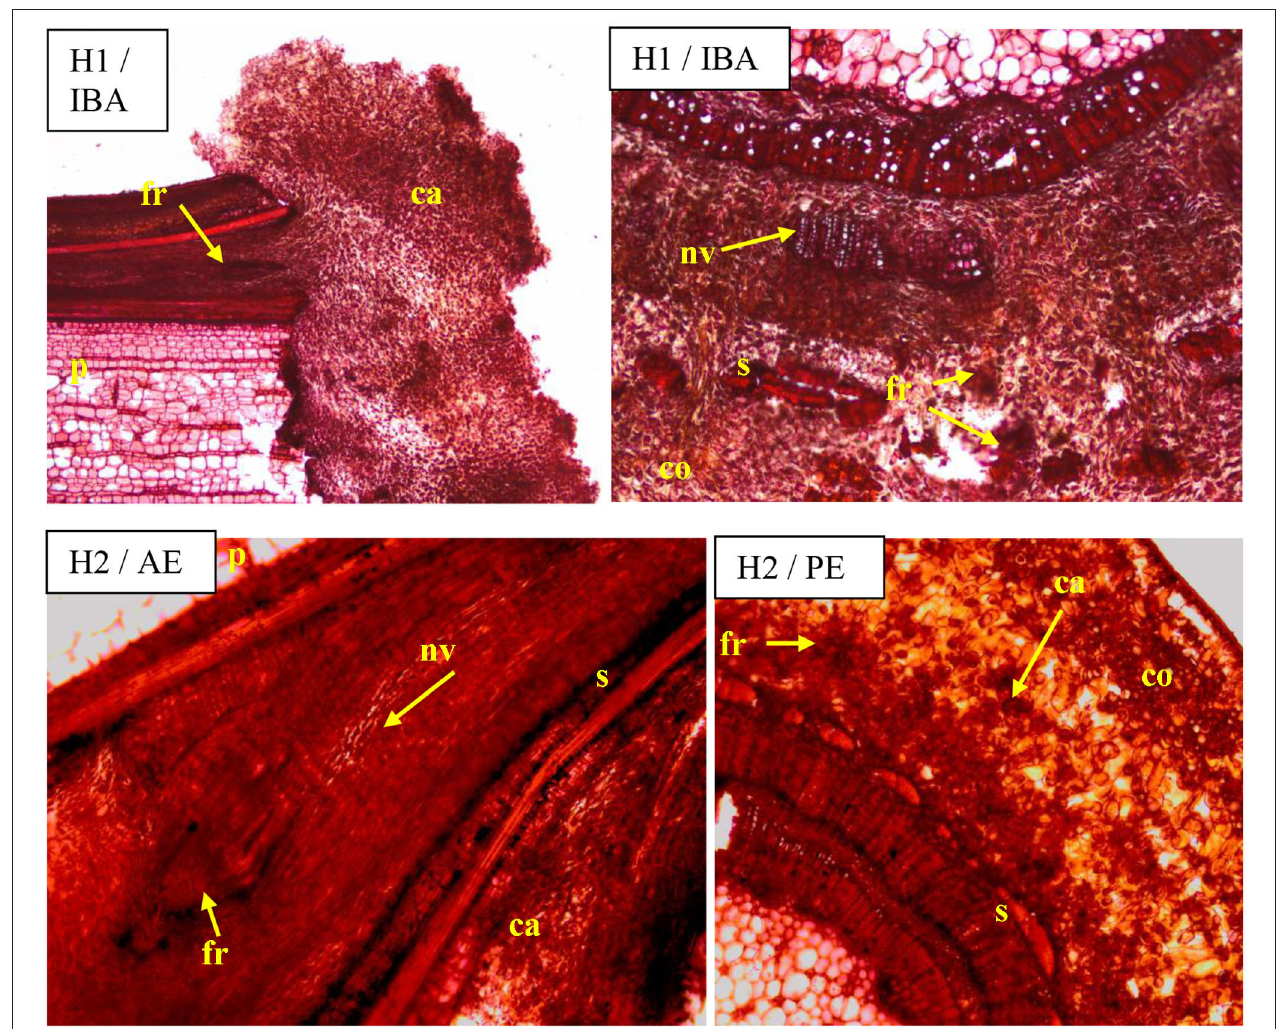
FIGURE 6 | Transverse and longitudinal sections of the shoots after 25 days of rhizogenesis rooting in Rosa “Hurdal” in four phenological stages in BBCH scale (Meier et al., 2009 ): H1 − 54 504 (flower buds still closed); H2 − 69 605 (full flowering; at least 50% of flowers open). IBA—Ukorzeniacz A aqua (0.4% IBA); AE—Algae extract—watering with 0.6% Bio Rhizotonic (10ml) after planting, 10 and 20 days later; PE—Plant extract—watering with 0.02% Bio Roots (10ml) after planting. Designation of signs: ca, callus; co, cortex; ph, phloem; p, pith; s, sclerenchyma; nv, new vascular bundles; fr, forming